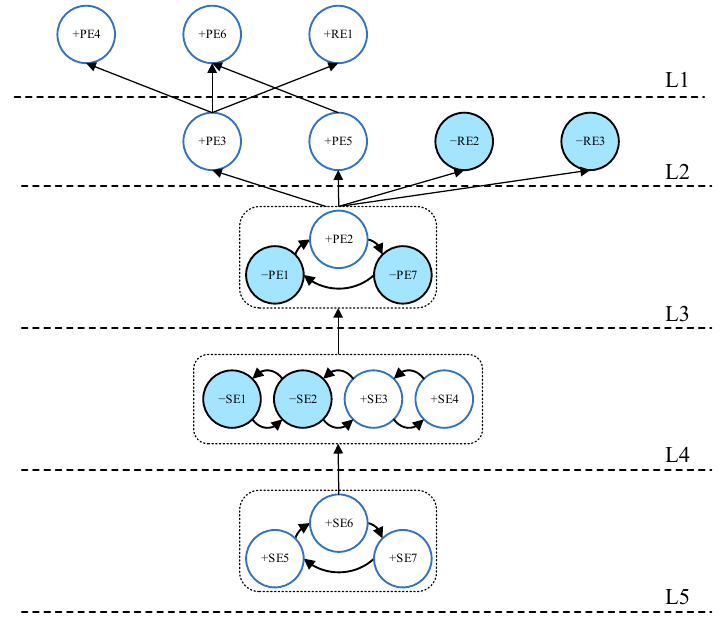
(cid:12) (cid:12) (cid:12) (cid:12) > (cid:12) C ij (cid:12)